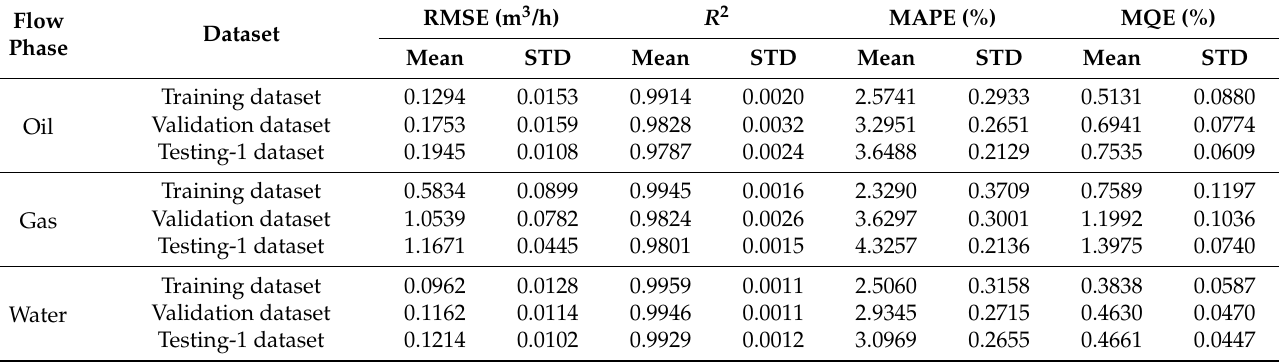
Table 5. Criteria for different datasets over 5 trials for different flow phases using the CNN-based prediction model. Flow